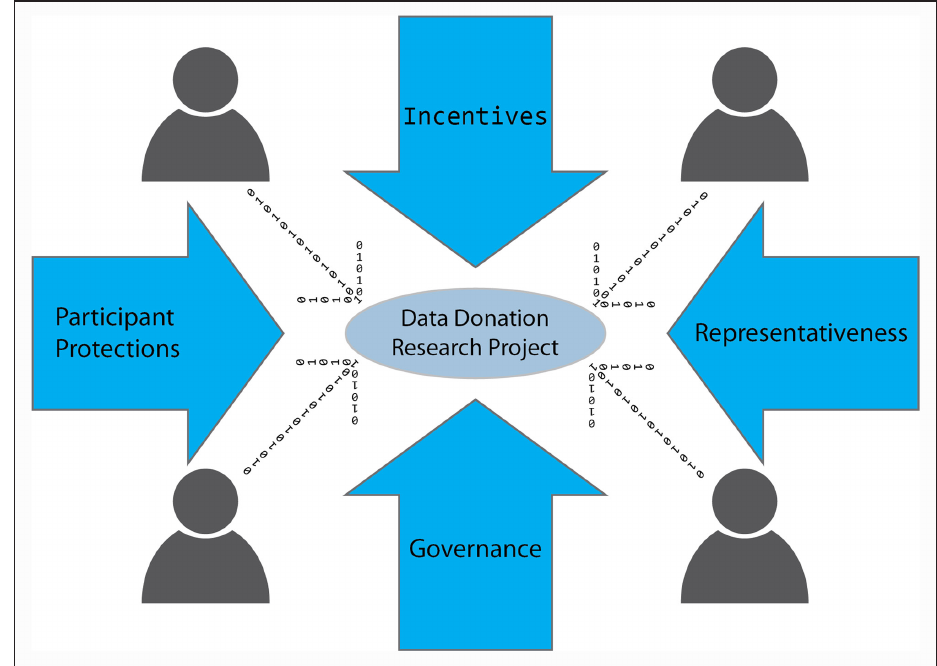
Figure 2: Participants in the Health Data Exploration Network Meeting identified four prominent themes for data donation citizen